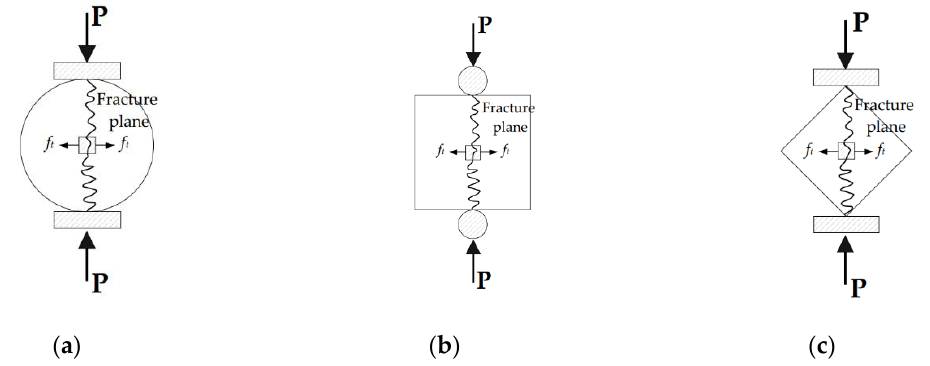
Figure 11. Test methods for splitting tensile strength. ( a ) Cylindrical specimen; ( b ) Cubic specimen (Case I); ( c ) Cubic specimen (Case II).